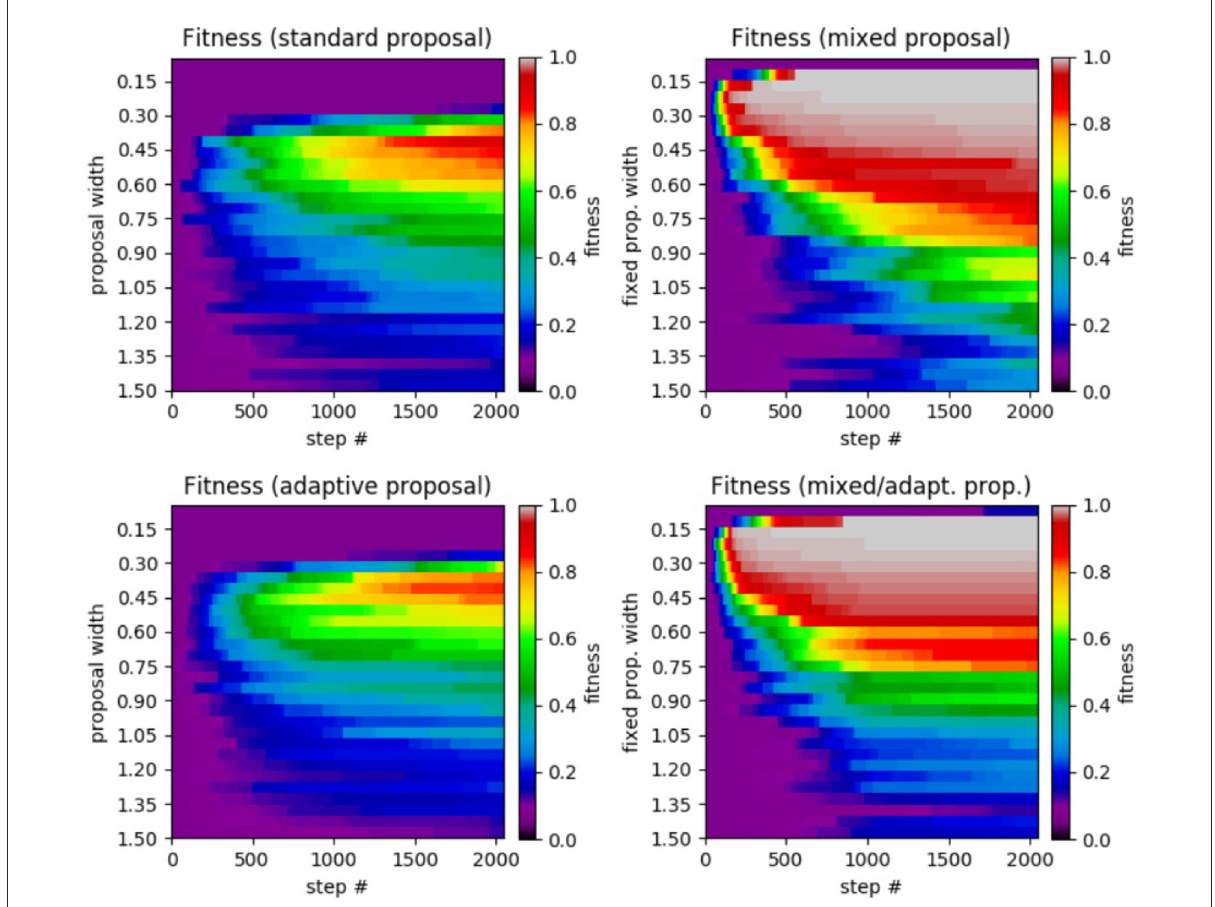
FIGURE3 Results of GA test on 5D Ackley function. (Top left) Standard GA. (Top right) Mixed GA. (Bottom left) adaptive GA. (Bottom right) Mixed/adaptive GA. The horizontal axis displays the step number while the vertical axis represents the the proposal width (increases downward). The color axis displays the average fitness across the 20 runs of each method.